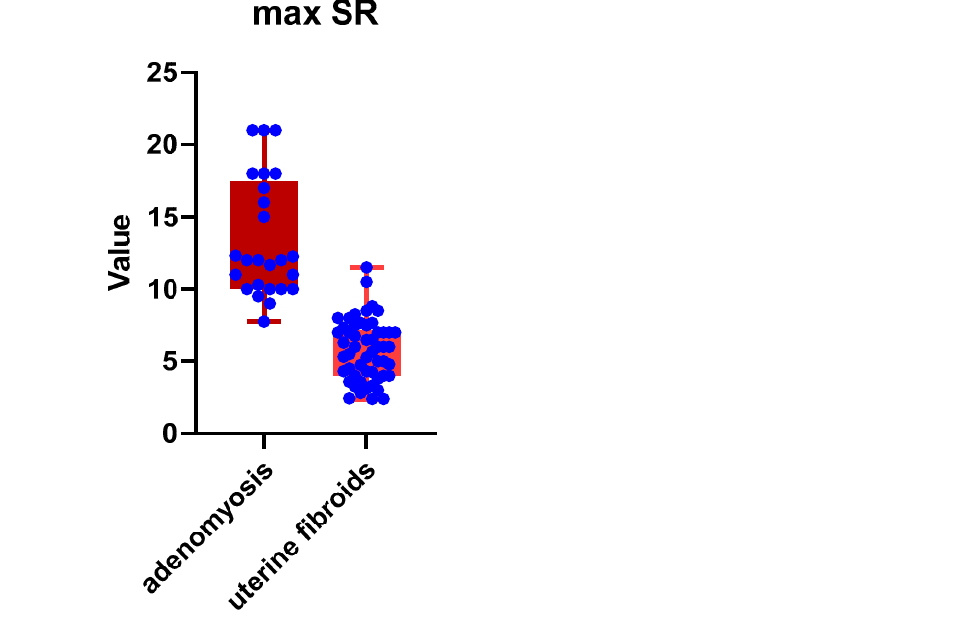
Figure 5. Distribution of max SR values among the two study groups. Legend: SR = strain ratio.